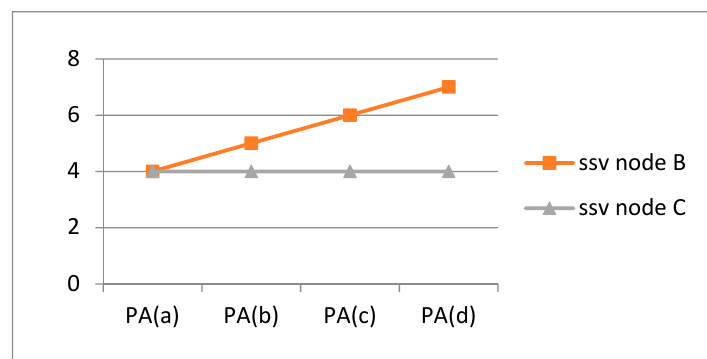
Figure 2. Preferential Attachment (PA) similarity score vectors (SSV) of nodes B and C with neighbors A, B, C, D, respectively.